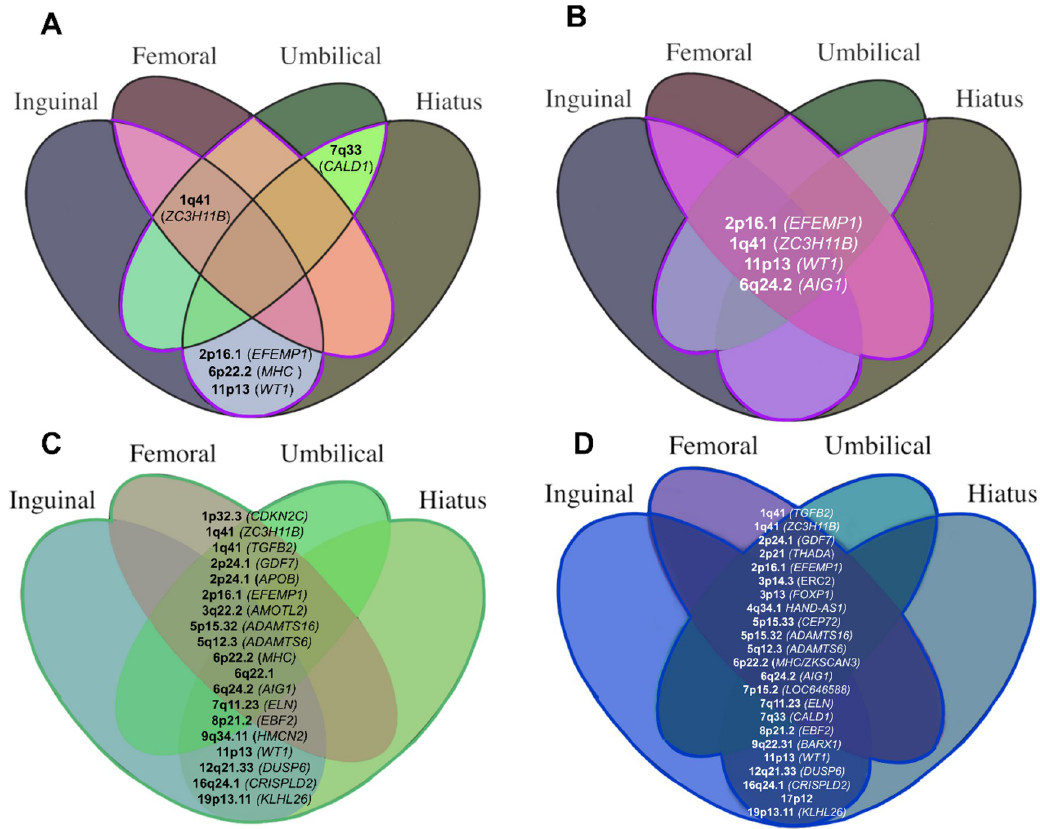
Fig 3. Shared susceptibility loci from individual, overlap and umbrella GWAS analyses as well as multivariable meta-analysis in metaUSAT. A: Individual hernia cohort: Evidence of shared susceptibility was demonstrated at five loci. B: Overlap hernia cohort: Evidence of shared susceptibility demonstrated at four loci. C: Umbrella hernia cohort: 19 loci became significant under umbrella hernia analysis. D: Multivariable meta-analysis in metaUSAT 24 loci were significant under meta-analysis (two loci at